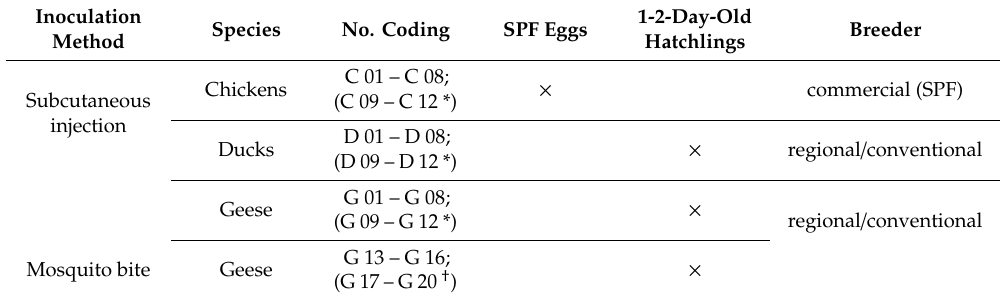
Table 1. Domestic avian species infected with West Nile virus (WNV) lineage 1 and their number coding and